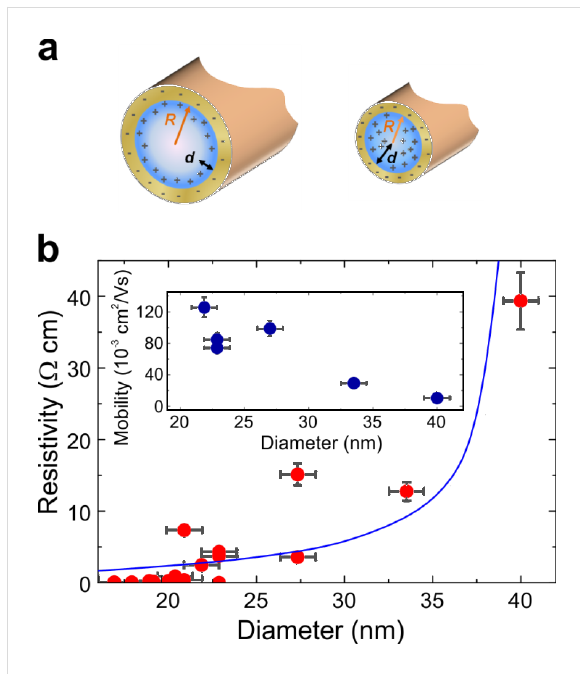
Figure 2: (a) Schematic diagram of the volume in which holes are pre- dominantly located for (left) a wire with a diameter above ≈ 20 nm and (right) for smaller diameters. The yellow region at the outside repre- sents the nanowire shell. Dark-blue area: region of free holes near to the core/shell interface. Light-coloured area: region devoid of free holes. Trapped electrons and free holes are schematically depicted by ( − ) and (+), respectively. (b) Comparison between theoretical model and experimental resistivity values for diameters larger than 22 nm. The model (blue line) follows qualitatively the observed experimental data. For smaller diameters a systematic deviation of the data is found indicating the limit of the validity of the model for these diameters. Inset: Calculated mobility values after Equation